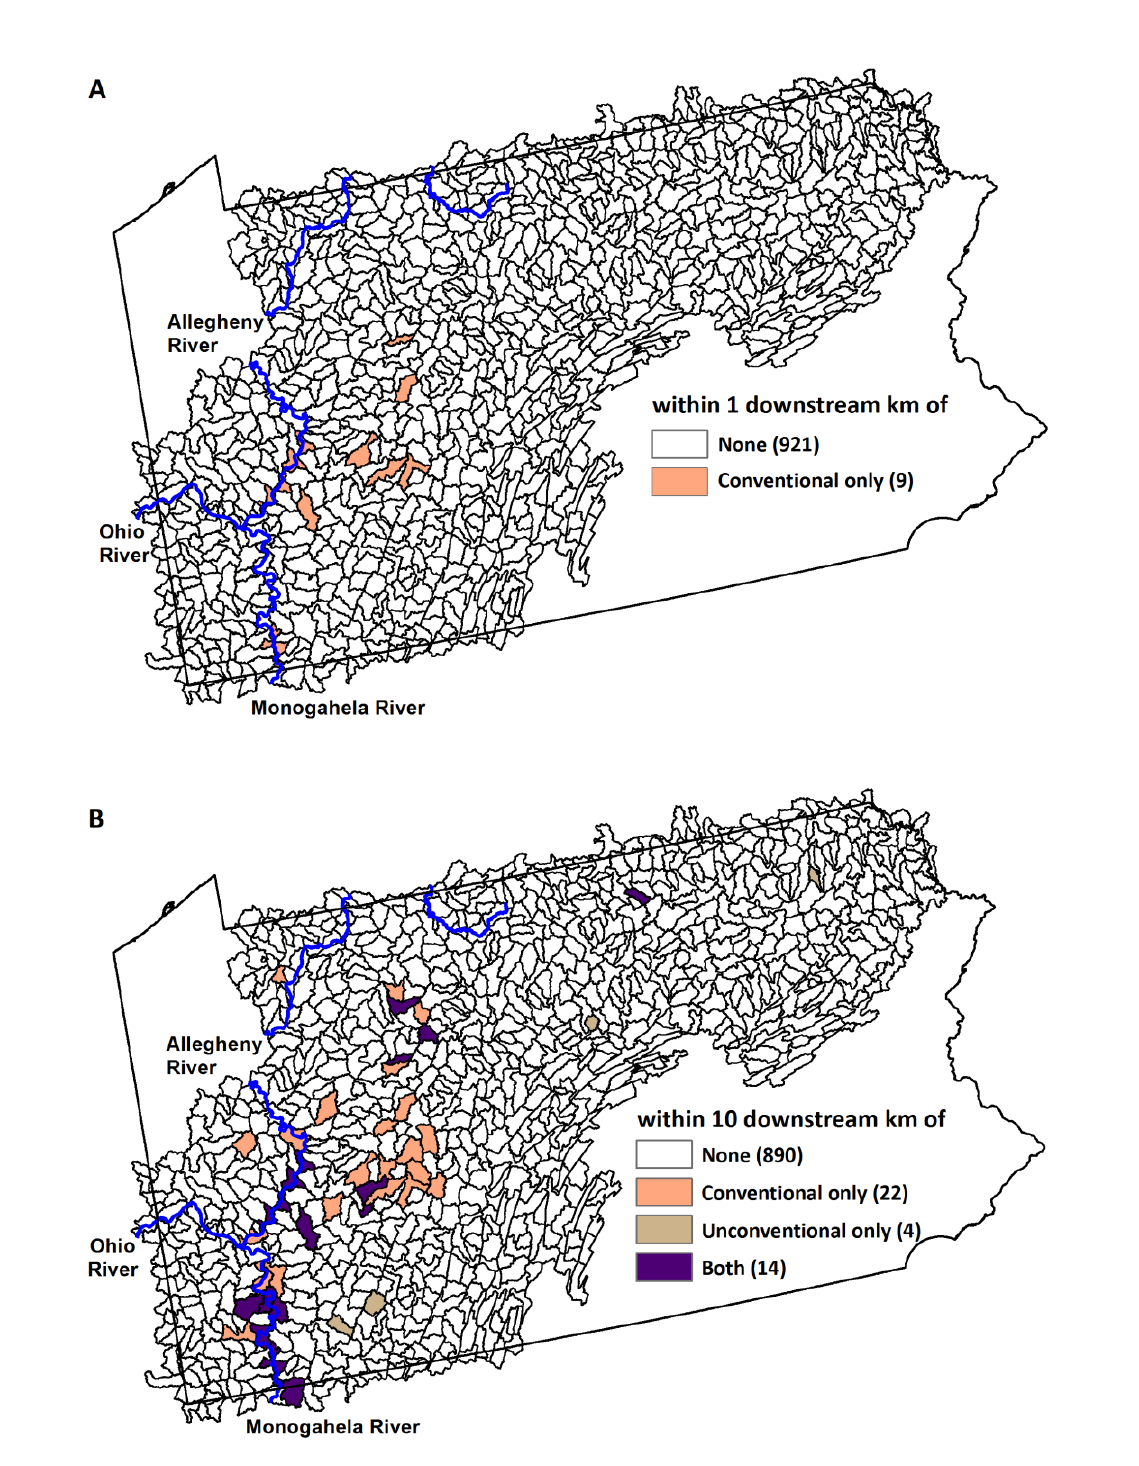
Figure 6. Surface drinking water intakes (DWI) within 1 km downstream ( A ) and 10 km downstream ( B ) of oil and gas development. Values in parentheses are the number of